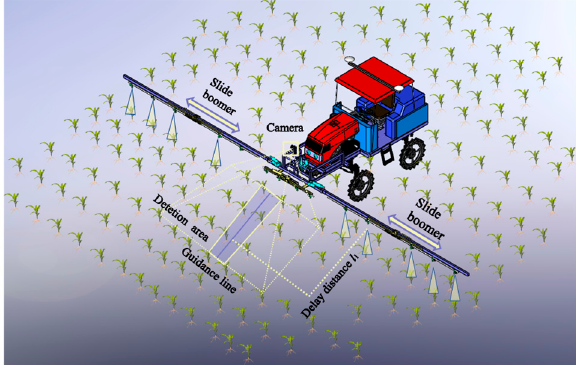
Figure 11. Visual row-oriented spraying platform in maize fields.